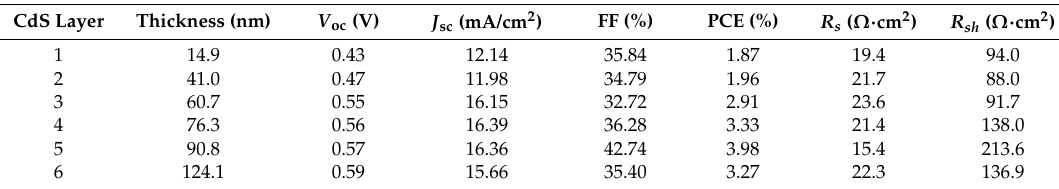
Table 1. Summarized performance of CdTe/CdS NC solar cells with different CdS thicknesses (Figure